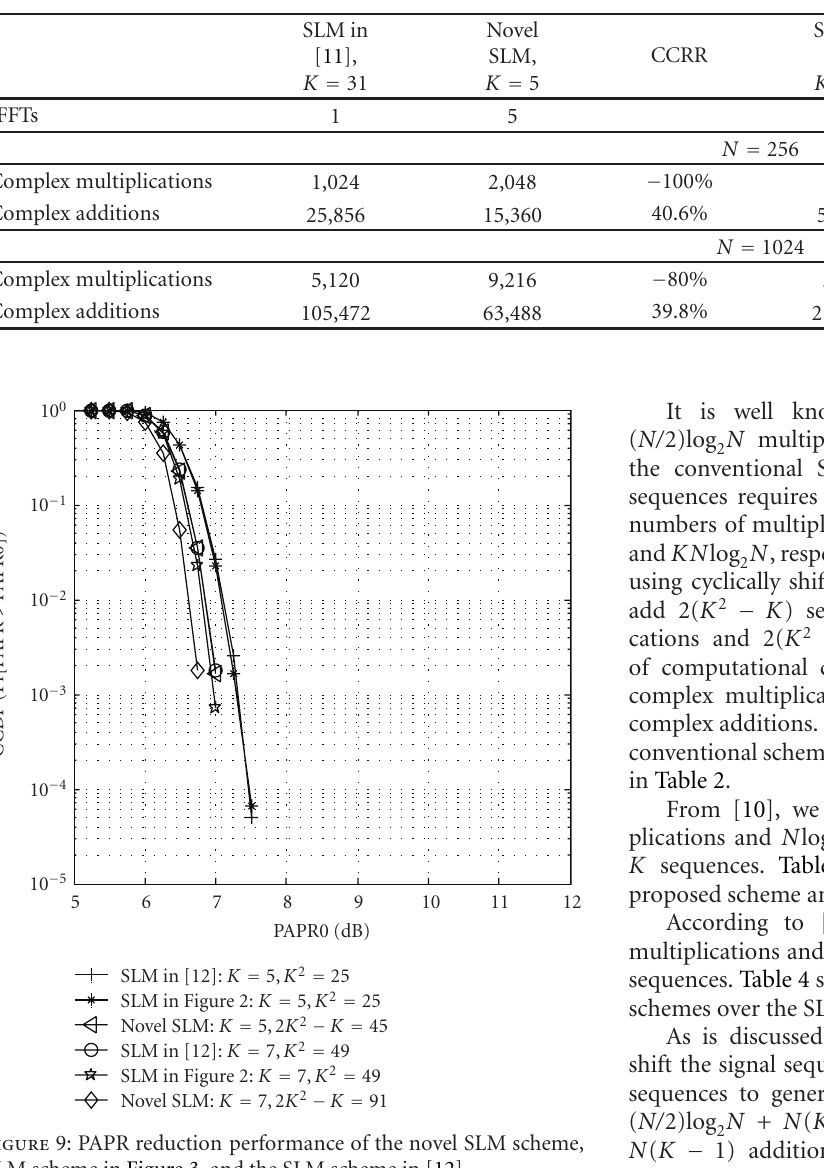
Table 4: Computational complexity of the SLM schemes in [11] and the novel SLM schemes when N = 256 and 1024.